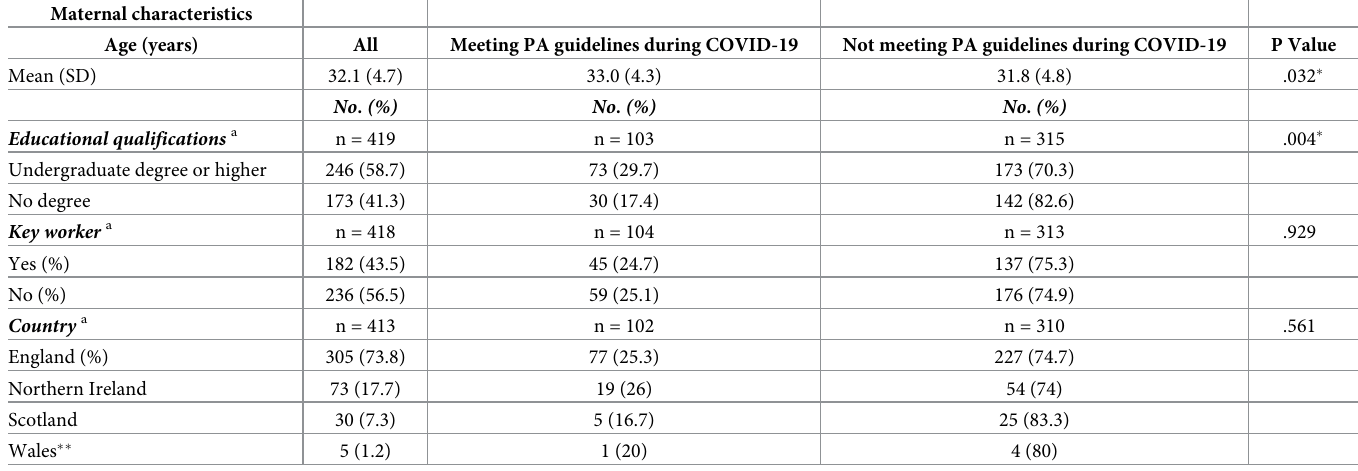
Table 1. Characteristics of respondents from online survey for pregnant women with GDM during COVID-19 pandemic according to meeting the physical activity guidelines/not meeting the physical activity guidelines. Maternal characteristics